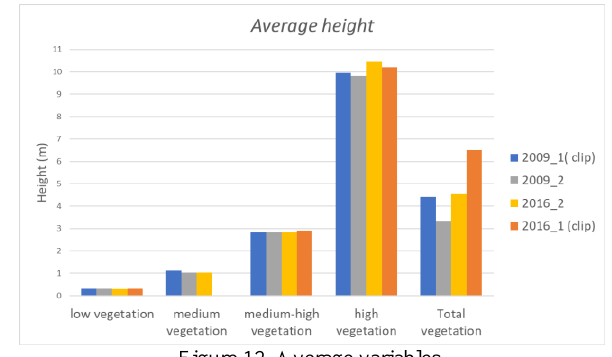
Figure 12. Average variables